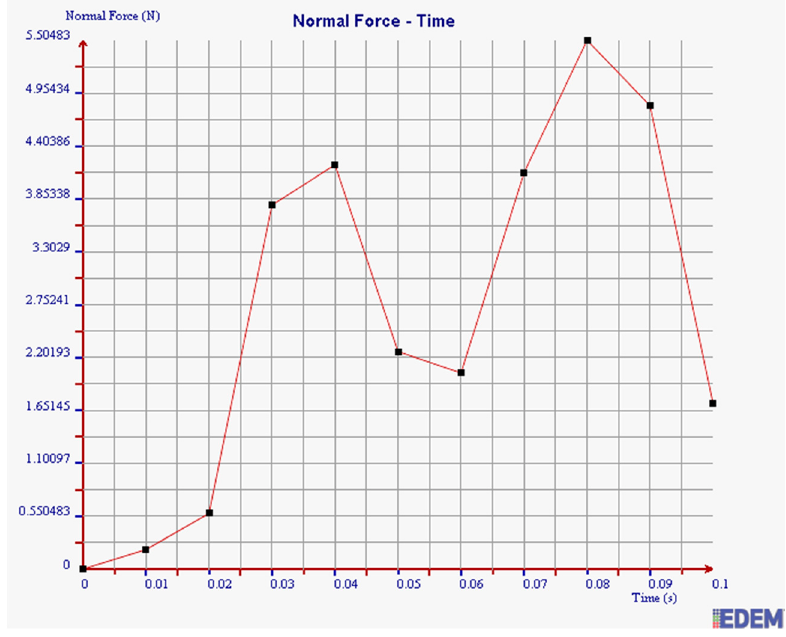
Figure. 14 Normal force of 2 mm steel balls. Figure 14. Normal force of 2 mm steel